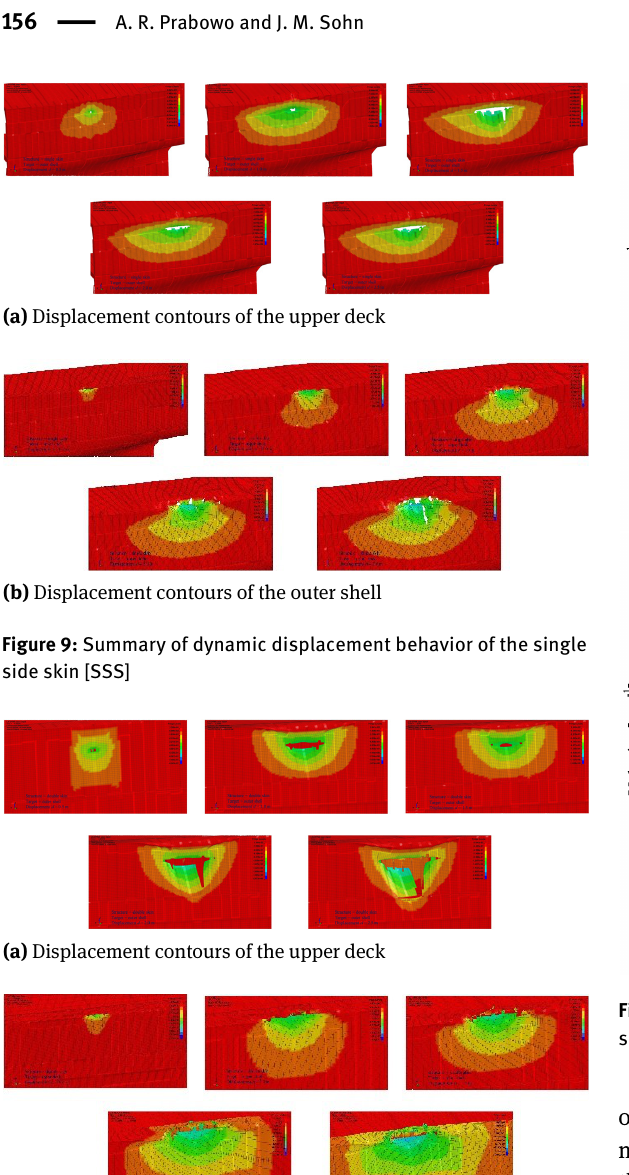
to the upper deck was more progressively expanding to the vertical direction compared to impact on the outer shell.